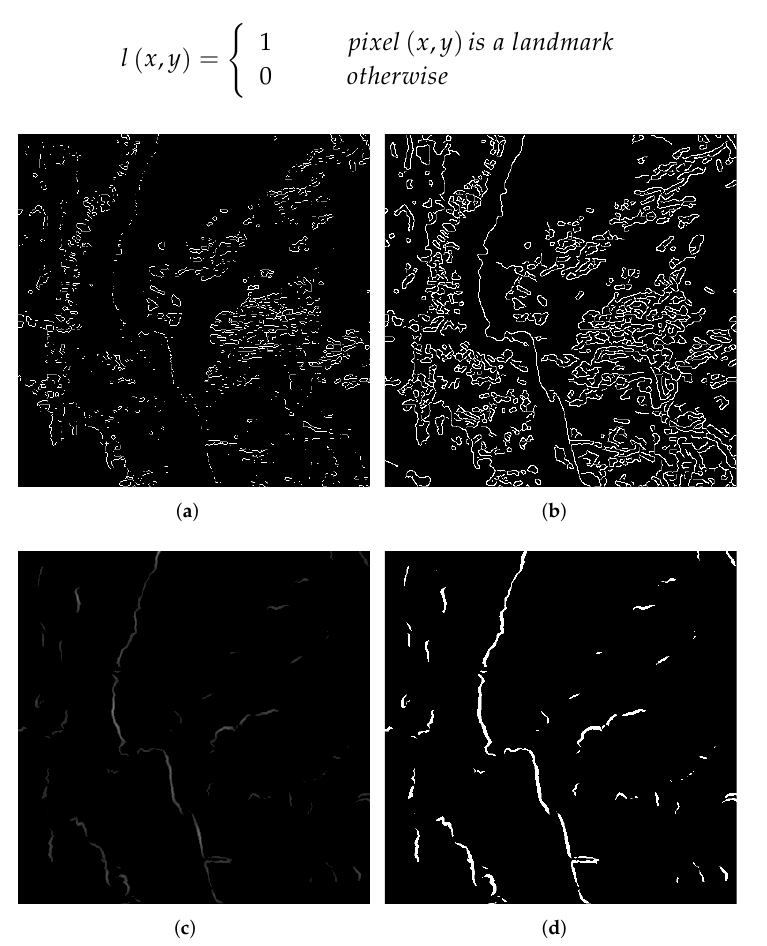
Figure 2. The edges of the GSMS image patch detected by different edge detectors. ( a ) The edges detected by Sobel detector; ( b ) The edges detected by Canny detector; ( c ) The edge probability map extracted by structured forests; ( d ) The feature map generated from the edge probability